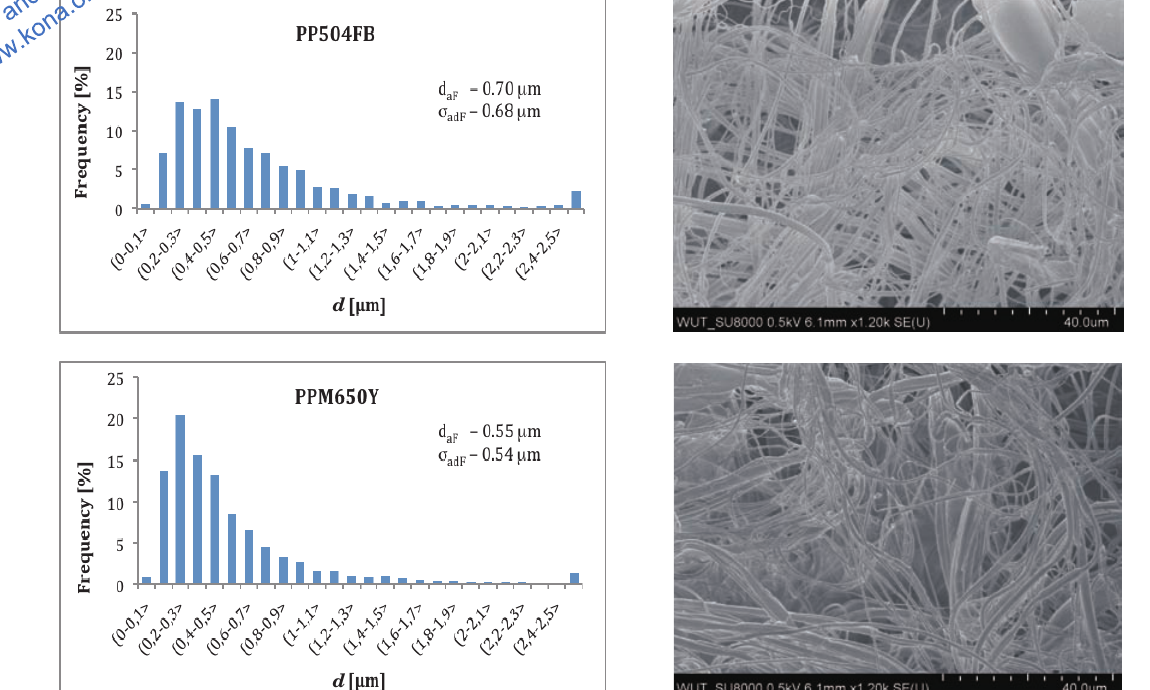
Fig. 5 HRSEM images and fiber diameter distributions of filters made of different polypropylenes: Borealis (Filter PP504FB) and Metocene (Filter PPM650Y).